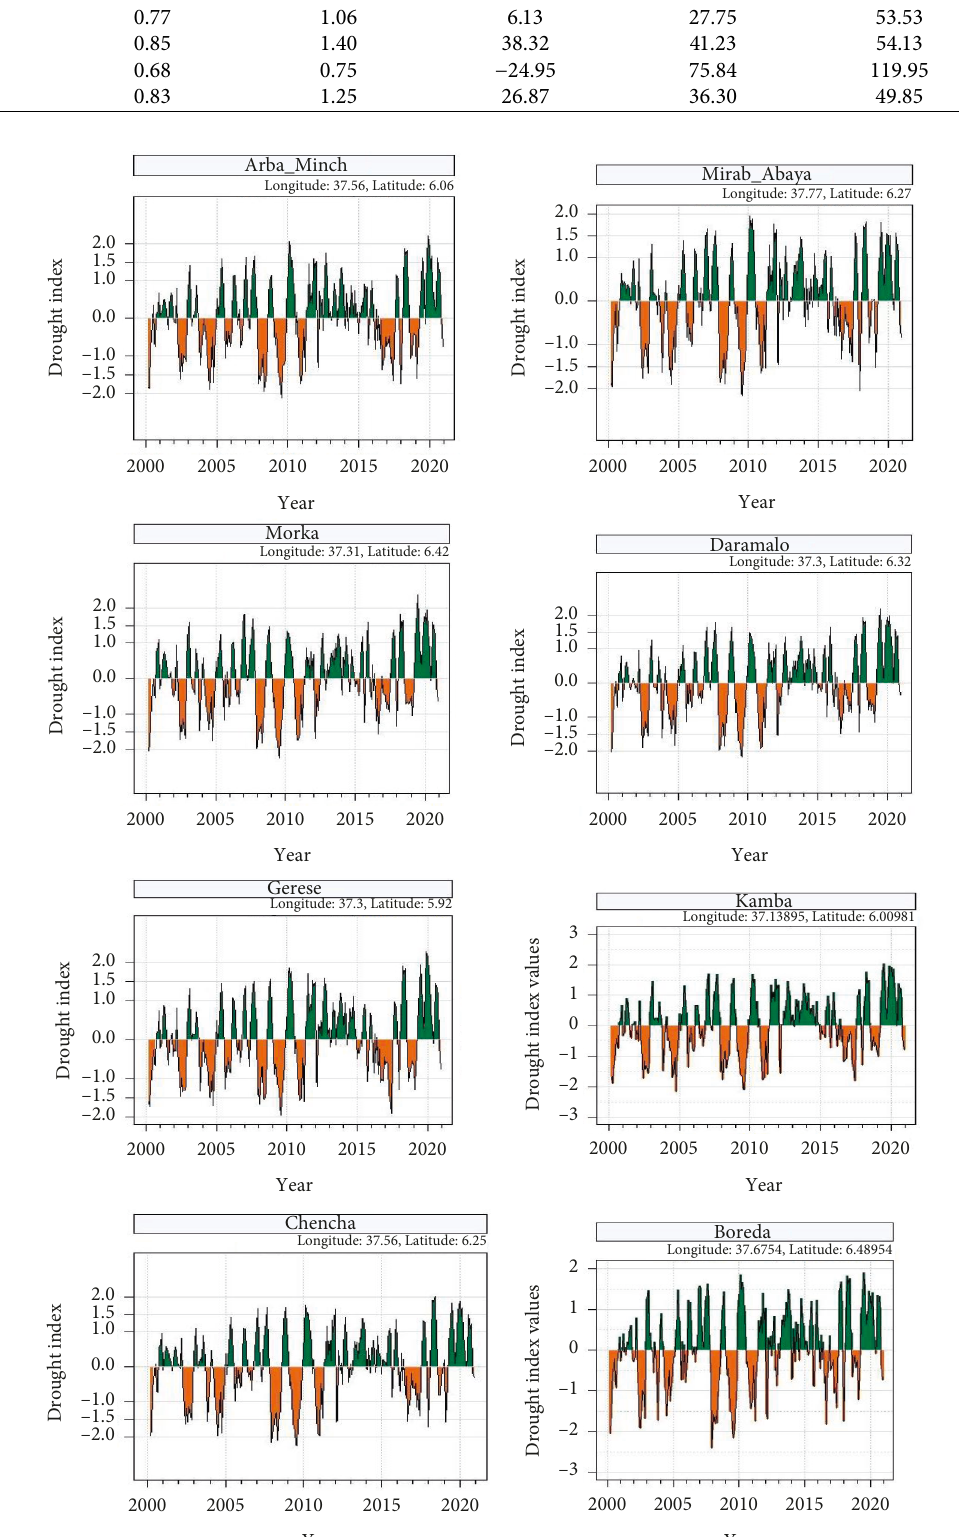
Figure 5: Time series plots of SPI-3 CHIRPS at eight selected stations for